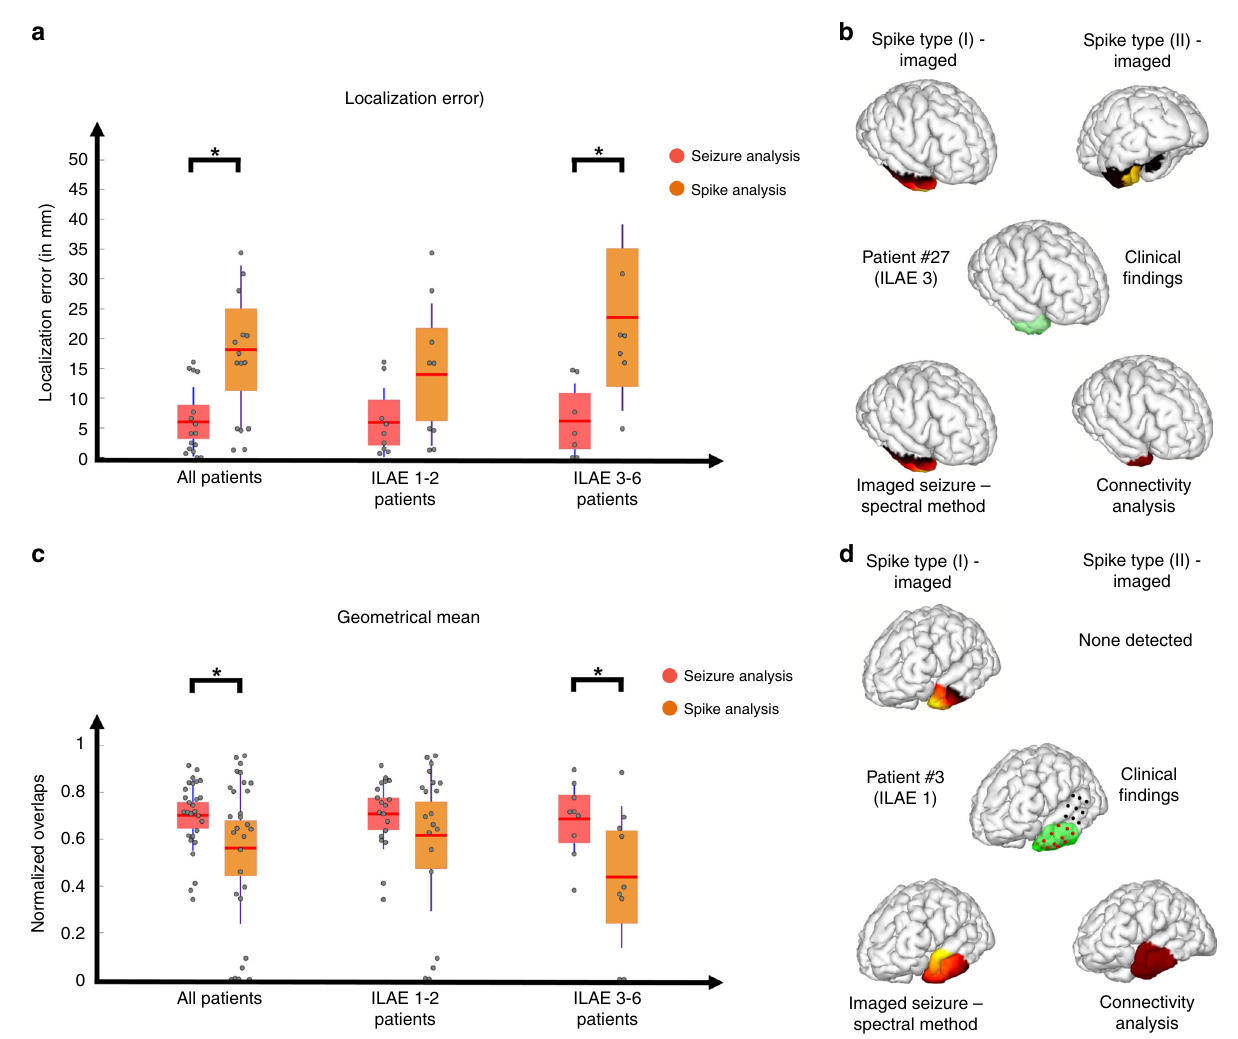
Fig. 6 Comparing spike imaging and ictal imaging results. a Localization error for spike and ictal imaging results are presented. Each gray circle corresponds to individual patient ’ s data. The red bar indicates the mean, the color bars indicate the 95% con fi dence interval for the mean and the dark bars indicate the standard deviation. The localization error in all patients ( n = 16) showed a signi fi cant difference (* p < 0.05) between the ictal and interictal imaging results (one-sided permutation test, p = 0.0015). Same results were observed for non-seizure-free patients ( n = 7, one-sided permutation test, p = 0.004), while seizure-free patients did not show such a strong trend ( n = 9, one-sided permutation test, p = 0.0476). b Geometric mean for spike and ictal imaging results; organization is same as in a . The geometric mean in all patients ( n = 29 for spike analysis and n = 28 for ictal analysis) showed a signi fi cant difference (* p < 0.05) between the ictal and interictal imaging results (one-sided permutation test, p = 0.0195). Same results were observed for non-seizure-free patients ( n = 9, one-sided permutation test, p = 0.0236), while seizure-free patients did not show such a trend ( n = 20 for spike